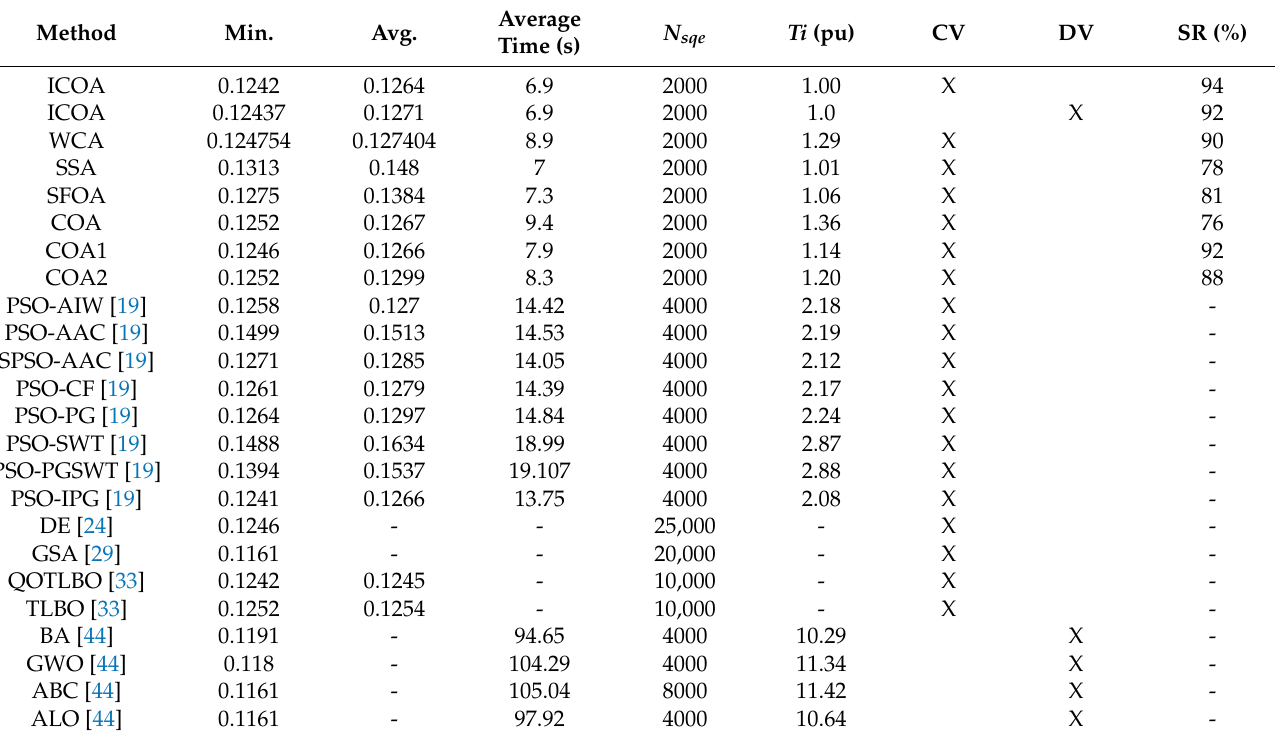
Table 7. Result comparison of L index for the IEEE 30-bus